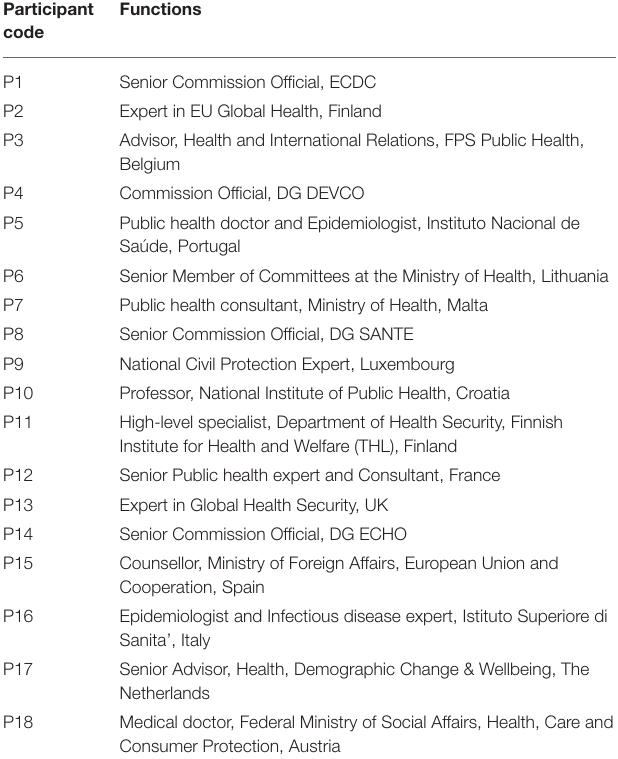
TABLE 1 | Study participants